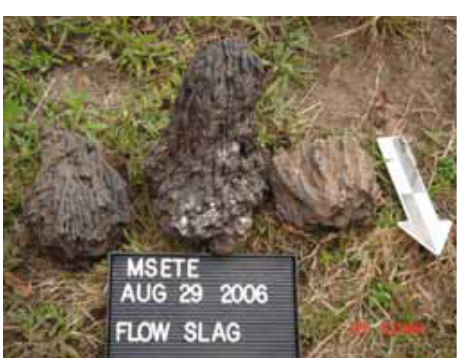
Fig 8: The smelting slags with flow